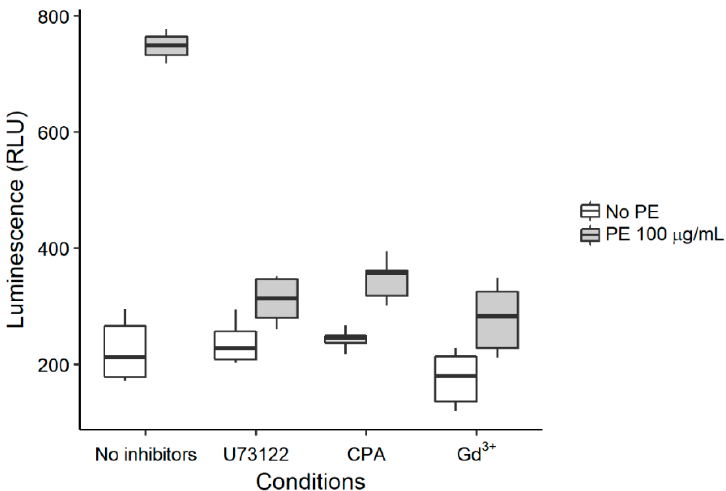
Figure 9. Inhibition of calcium signaling prevents phosphatidylethanolamine (PE)-induced apoptosis. Ninety-six well plates were seeded with 20,000 cells and incubated for 48 h in free serum medium with 100 µ g · mL − 1 PE in the absence or in the presence of U73122 (10 µ M), CPA (5 µ M) and gadolinium (5 µ M). Apoptosis was measured by using the Caspase-Glo 3/7 assay (Promega). Asterisks indicate significant differences ( p < 0.05, ANOVA with post-hoc Dunnett test against the control).